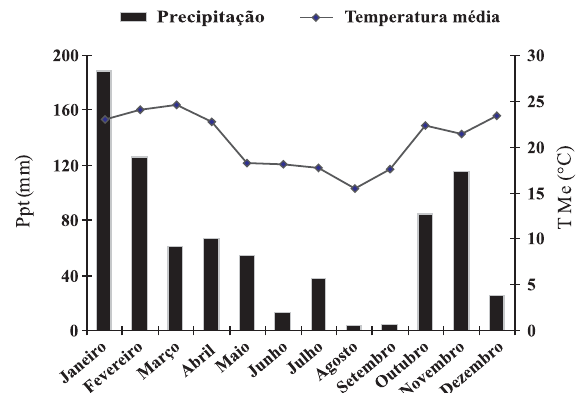
Figura 1. Temperatura média e precipitação pluvial do ano de 2007 do município de